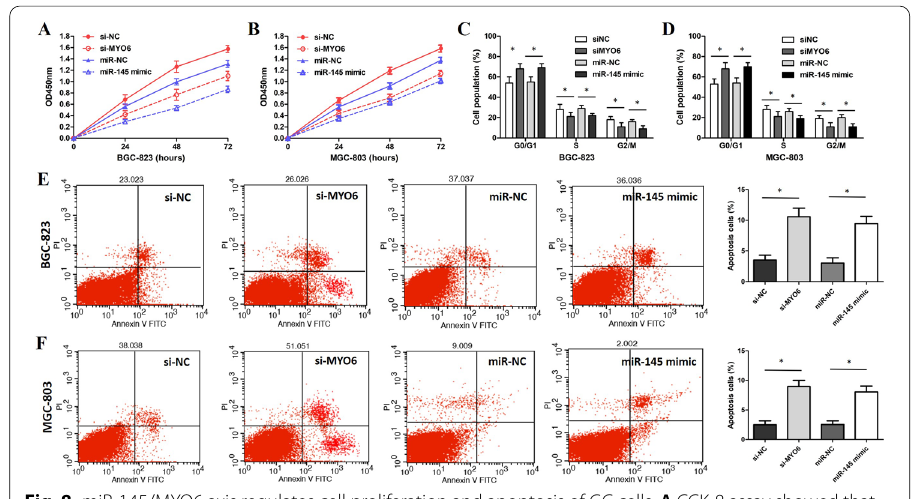
Fig. 8 miR-145/MYO6 axis regulates cell proliferation and apoptosis of GC cells. A CCK-8 assay showed that MYO6 knockdown or miR-145 mimics inhibited cell proliferation of BGC-823 cells. B CCK-8 assay showed that MYO6 knockdown or miR-145 mimics inhibited cell proliferation of MGC-803 cells. C BGC-823 cells transfected with siMYO6 or miR-145 mimics induced G0/G1/ phase arrest. D Flow cytometry assay showed that MGC-803 cells transfected with siMYO6 or miR-145 mimics had G0/G1 phase arrest. E Flow cytometry assay showed that BGC-823 cells transfected with siUCA1 or miR-145 mimics had a higher apoptotic rate. F Flow cytometry assay verified that UCA1 knockdown in MGC-803 cells by siUCA1 transfection induces apoptosis. *p < 0.05, compared with control